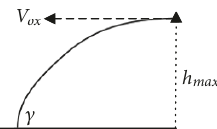
Figure 5: Velocity determination for rotary-wing